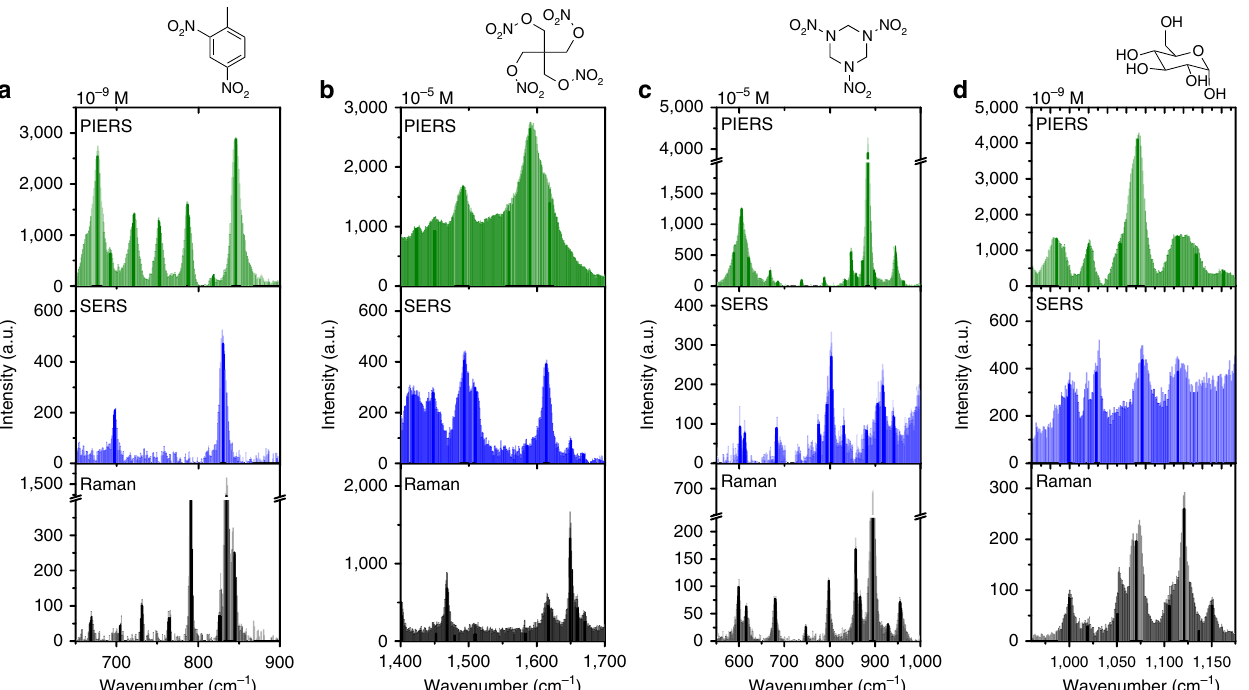
Figure 4 | Comparative PIERS spectra of explosives and biomolecules. Raman of pure solid (black), SERS (blue) and PIERS (green) of molecules of interest on a gold nanoparticle/TiO 2 substrate. Darker lines indicate the positions of spectral maxima to aid comparison. SERS and PIERS samples deposited from identical volume of solution: ( a ) 10 (cid:2) 9 M dinitrotoluene (DNT), ( b ) 10 (cid:2) 5 M pentaerythritol tetranitrate (PETN), ( c ) 10 (cid:2) 5 M cyclotrimethylenetrinitramine (RDX), ( d ) 10 (cid:2) 9 M glucose. Raman spectra collected from pure reference powders/liquids. Each spectrum was collected with the same conditions, giving the increase in intensity for the PIERS spectra, and full collection details are given in the Methods, along with full spectra in Supplementary Fig.